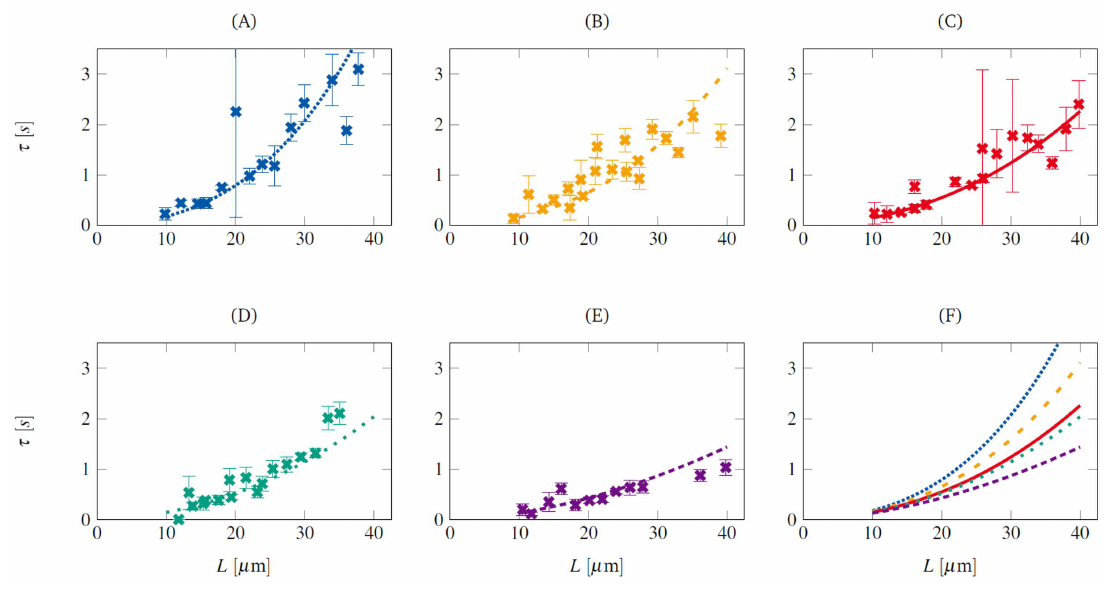
Figure 12. Experimental results on the relaxation of long-chain ds-DNA molecules under moderate confinement [106]. Each sub-plot shows the variation of the longest relaxation time with the molecular contour length, confined in microchannels of height ( A ) 2.5 µ m, ( B ) 3.6 µ m, ( C ) 6 µ m, ( D ) 7.6 µ m and ( E ) 70 µ m. Sub-plot ( F ) shows the comparison of the relaxation time in different degrees of confinement.